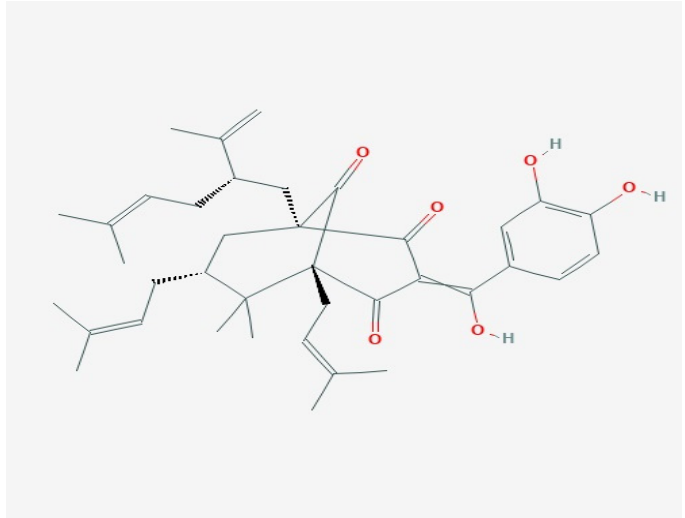
Figure 2. Garcinol structure. Accessed from pubchem.ncbi.nlm.nih.gov [39]. Other potential sources of garcinol are G. cambogia, G. morella, G. yunnanesis, G. xan- tochymus, G. travancorica, and G. Buchananii [38]. Garcinol can be obtained by methanol extraction followed by multi-step evaporation and absorption reactions (column chro- matography absorption; reviewed in [40]). Dried fruit of G. Indica contains around 2.5% garcinol when measured with High-Performance Thin Layer Chromatography (HPTLC). Studies of garcinol’s chemical structure revealed that the effects of this substance are the result of specific chemical groups in its molecular structure. The C-3 ketonic group and phenolic ring with hydroxyl attachments are the oxidation sites. 1,2-Carbon double bond α , β -unsaturated ketones have been found to be crucial for apoptosis induction. Double bonds in the isoprenyl ring are responsible for the antioxidative properties of garcinol, while 13,14-dihydroxy groups and C8 side chains are key functional groups for anti-cancer effects as shown in in vitro experiments [41,42]. Recently, garcinol was shown to exert anticancer effects on cancer cell lines, in vitro cultures, and in vivo experiments in animal models (Table 3)